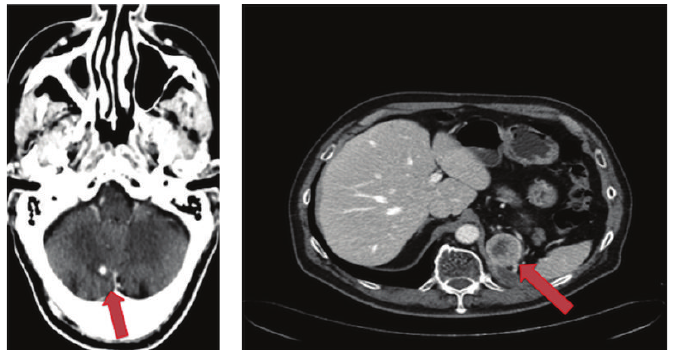
Figure 1: Before starting pazopanib a cerebellar lesion of 6 mm in diameter appeared and left adrenal gland solid nodule was 4cm in size, with a little necrotic core.